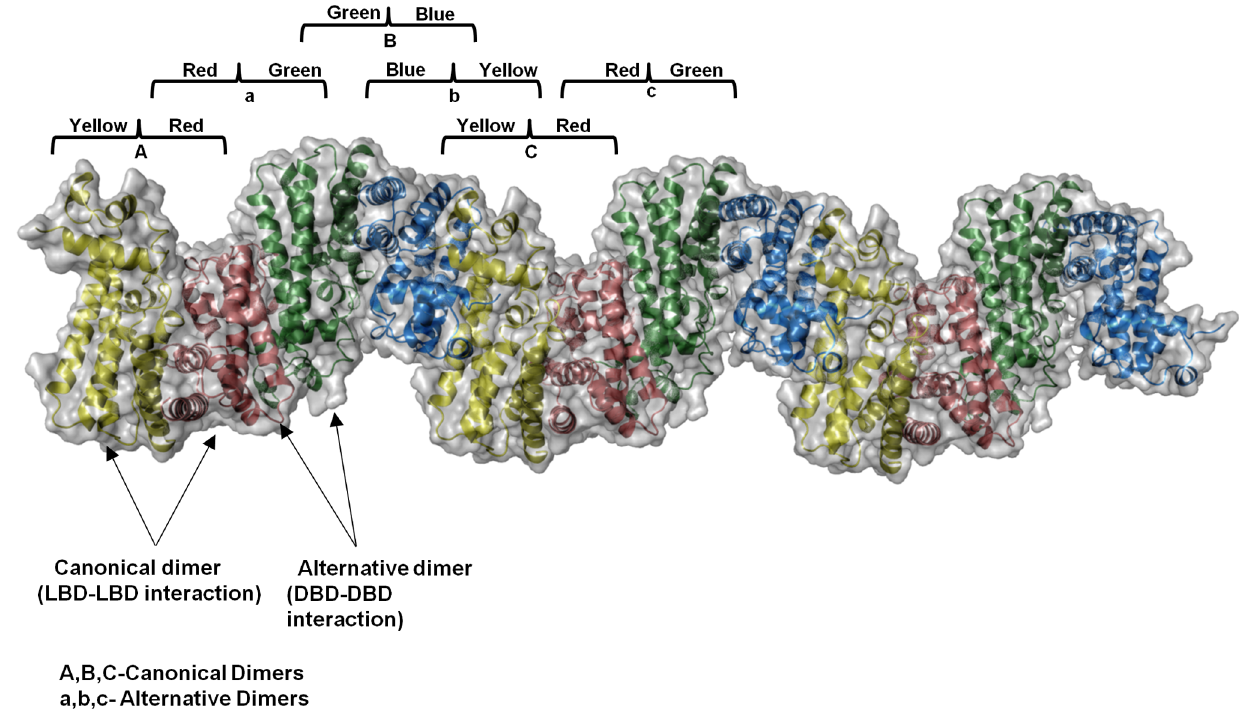
Fig 3. Crystal packing representations of canonical and alternative dimers. View of repeating alternate quaternary states; alternate arrangement of two canonical dimers (yellow-red, labeled as "A" and green-blue labeled as "B") and alternative dimers (red-green, labeled as "a" and blue-yellow, labeled as "c" repeat along the y-axis and form a tetrameric